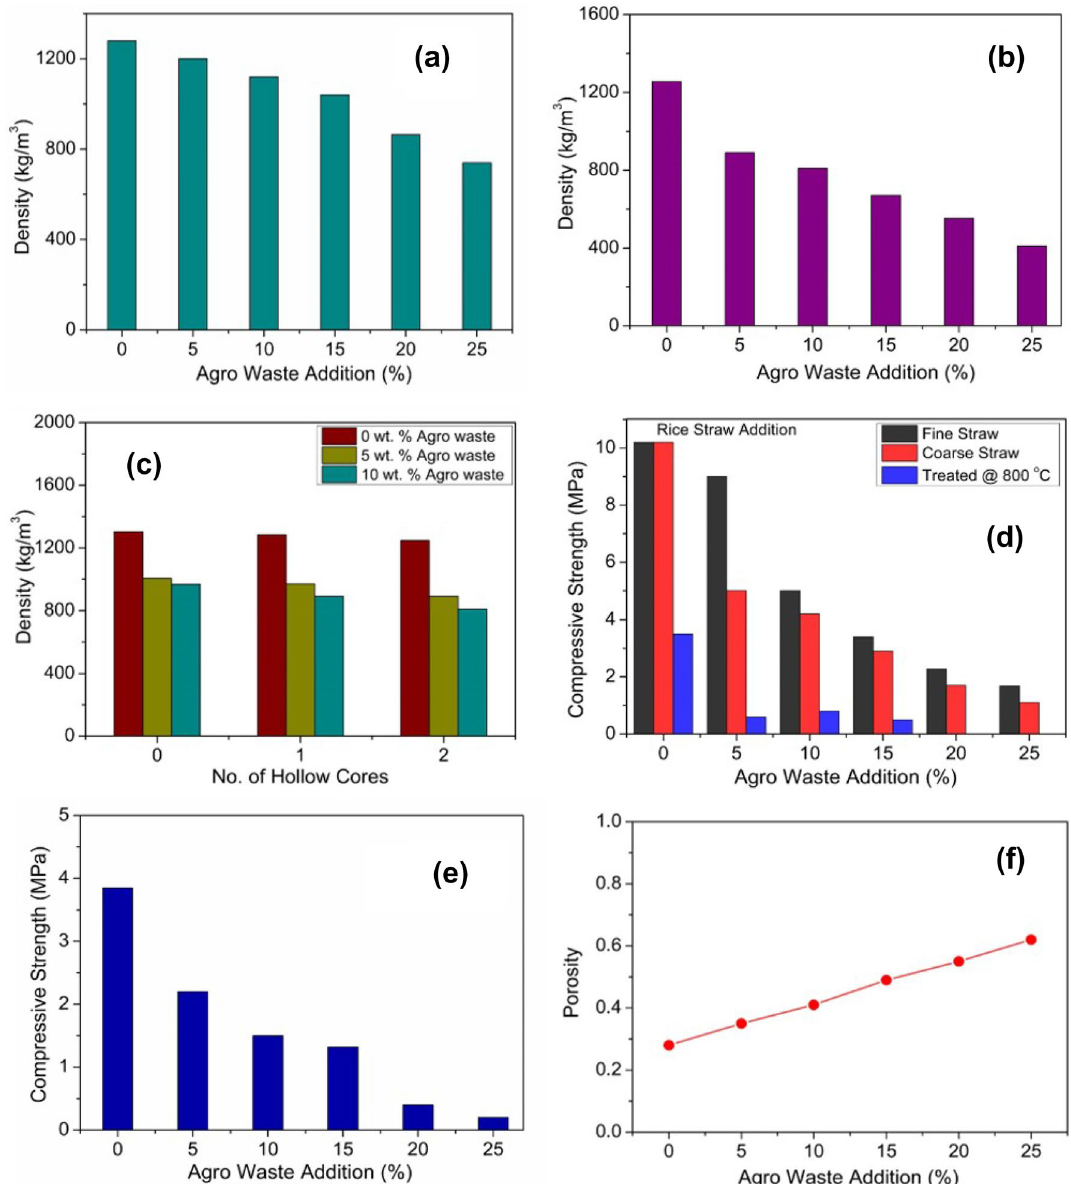
( d ) compressive strength of rice straw added gypsum cubes of various straw size and treatment at 800 °C; ( e ) compressive strength of rice straw added gypsum two-core hollow blocks; ( f ) porosity variation of gypsum and rice straw based